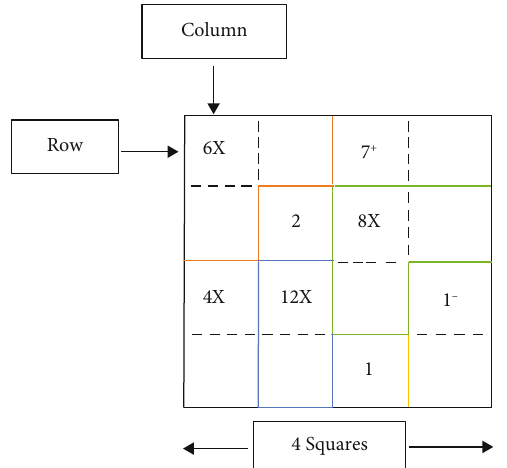
Figure 6: An example of a 4 × 4 rebus pattern with 8 cages considered for this study.